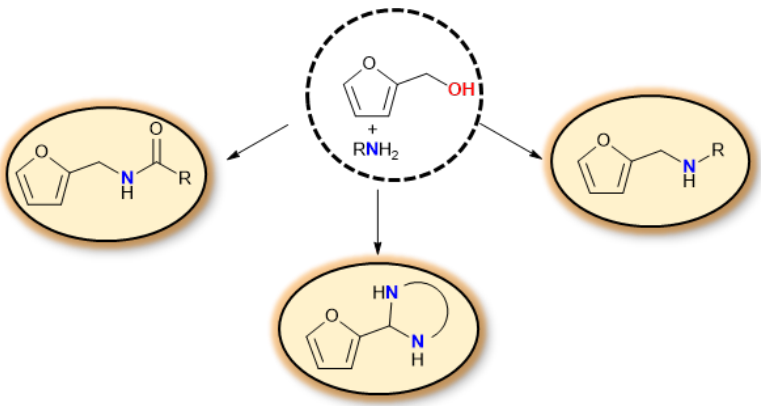
Table 2. Catalytic furfuryl alcohol amination with a primary amine as a nitrogen